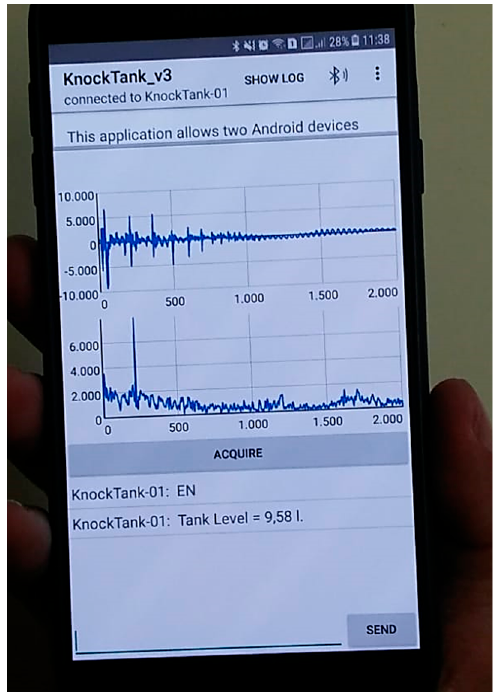
Figure 9. Real use-case of the Android application.